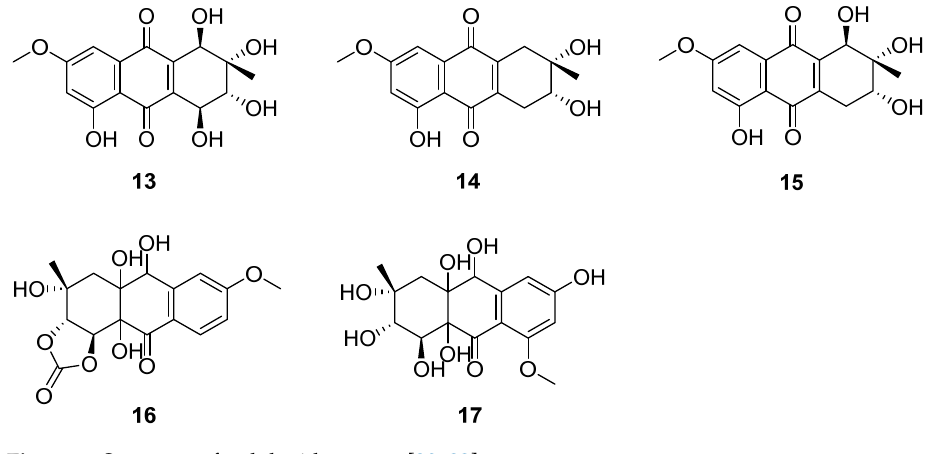
Figure 6. Structure of polyketides 13 – 17 [30–32].